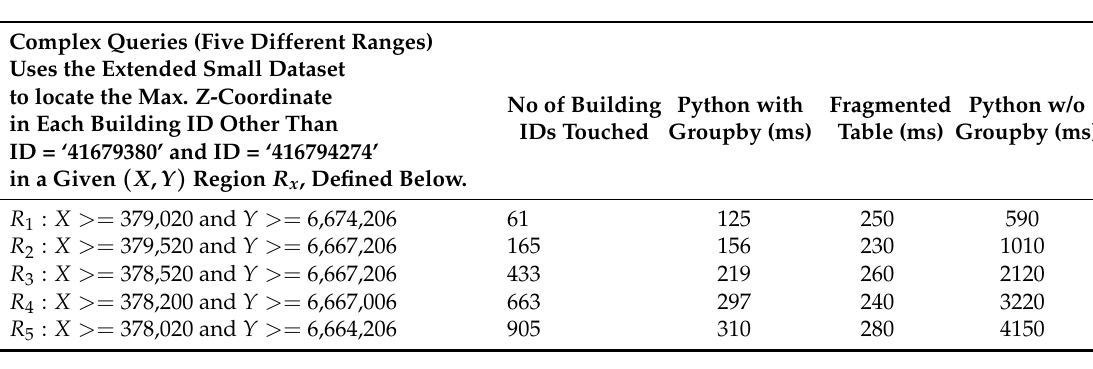
Table 8. The five more complex queries that access the extended small dataset and their completion times in milliseconds for three different implementations. The column ‘No of building IDs touched’ refers to the number of building IDs that contributed points towards the query. The hot query times for the fragmented table (fourth column) were almost identical to the cold query times and are therefore not